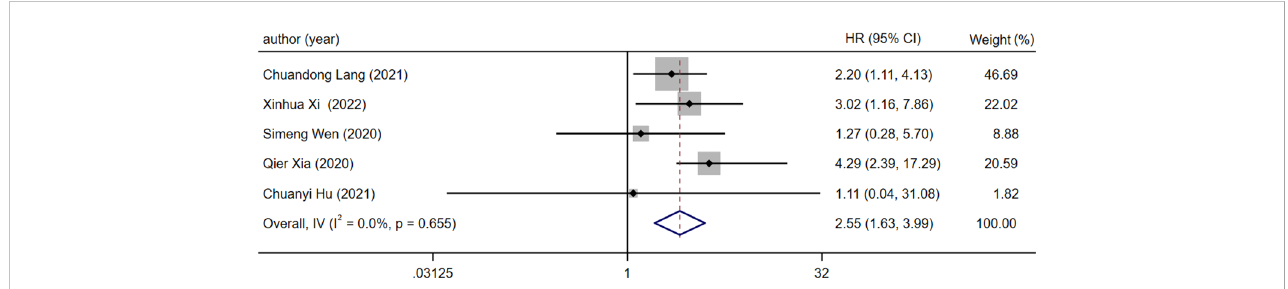
FIGURE 2 Forest plot of meta-analysis of the relationship between lncRNA expression and OS in prostate cancer patients with bone